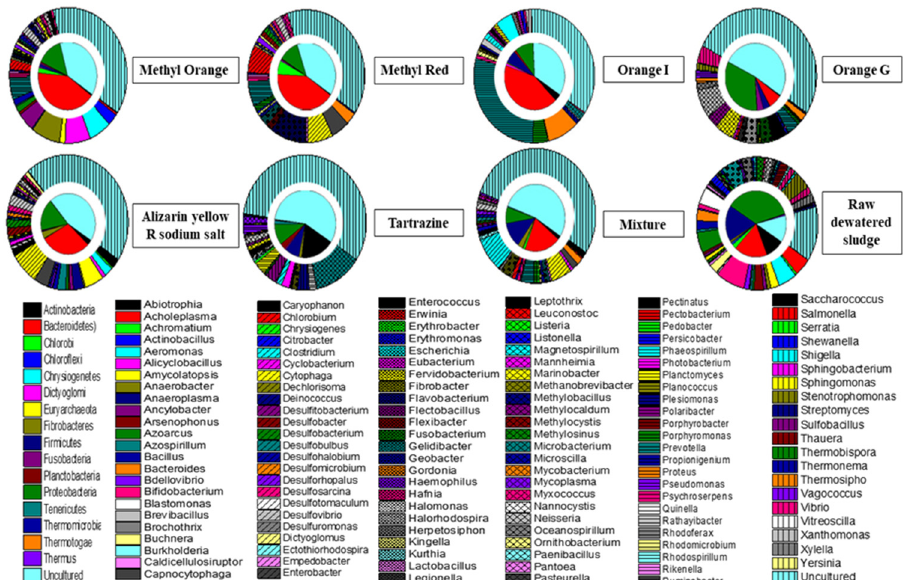
Figure 5. Double pie charts of microbial communities in activated sludge after acclimatization with different azo dyes. The inner pie represents the compositions of phyla, and the outer pie shows the compositions of genera. Above the pie is the azo dye used in each treatment system except the initial dewatered sludge. For better understanding, a color view is recommended.